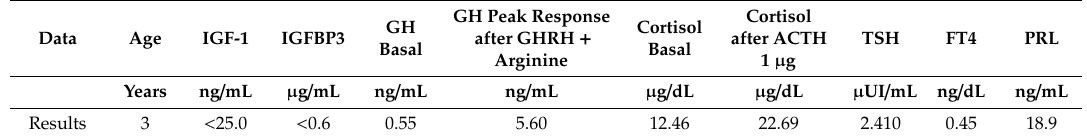
Table 1. Hormonal evaluation of anterior pituitary function in the affected child. GH: growth hormone. IGF1: insulin-like growth factor 1. TSH: thyroid stimulating hormone. PRL: prolactine. The immuno-chemiluminometric assay measured all hormones.